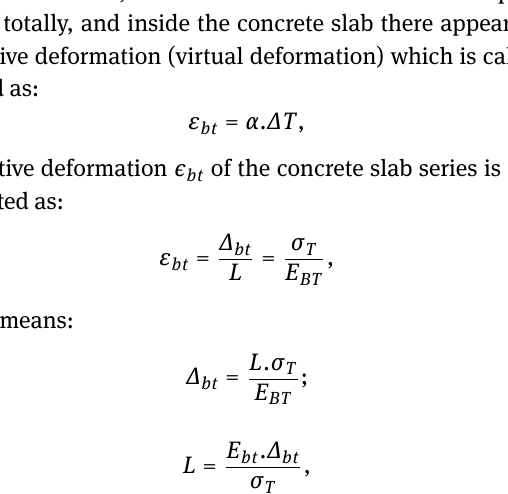
√︁ ( H = 225, 08 2 − 225, 0 2 = 6 cm